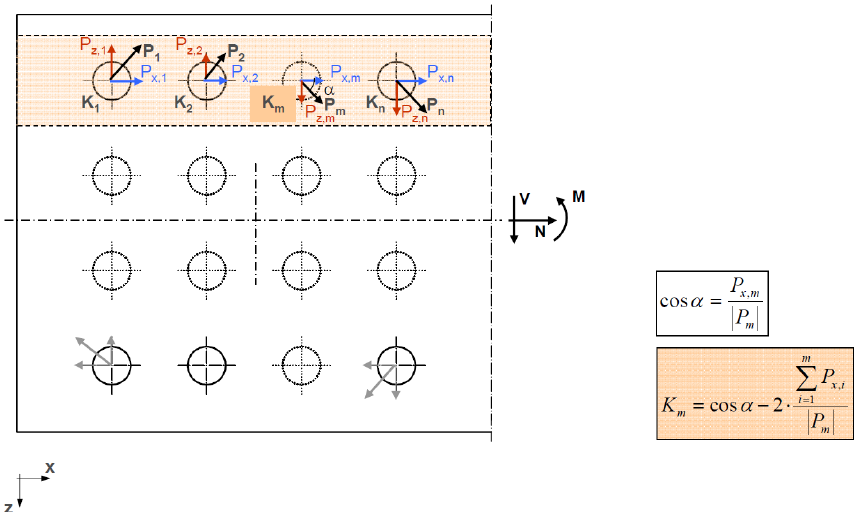
Figure 9: Determination of the parameter K m for joints loaded by normal and shear load as well as by moment at example of investigated